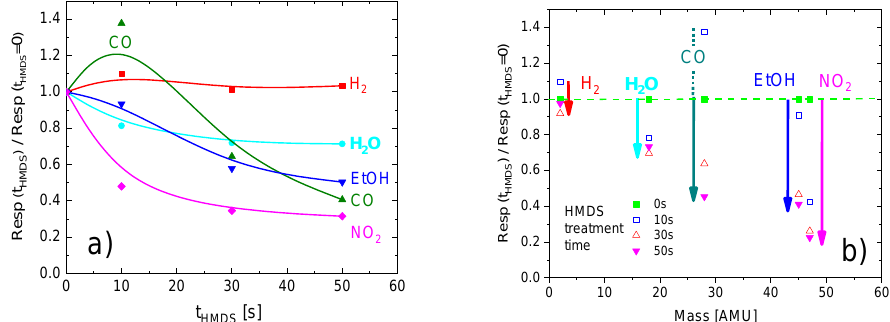
Figure 3. ( a ) Change in relative resistance response 𝑅𝑒𝑠𝑝 with HMDS treatment time for analytes with different molecular masses; ( b ) change in relative resistance response with analyte molecular mass after different-length HMDS treatments. Analyte concentrations were 20 ppm (H 2 , EtOH, NO 2 ) and rh = 80%, respectively. Arrows indicate losses in relative resistance response with HMDS passivation.